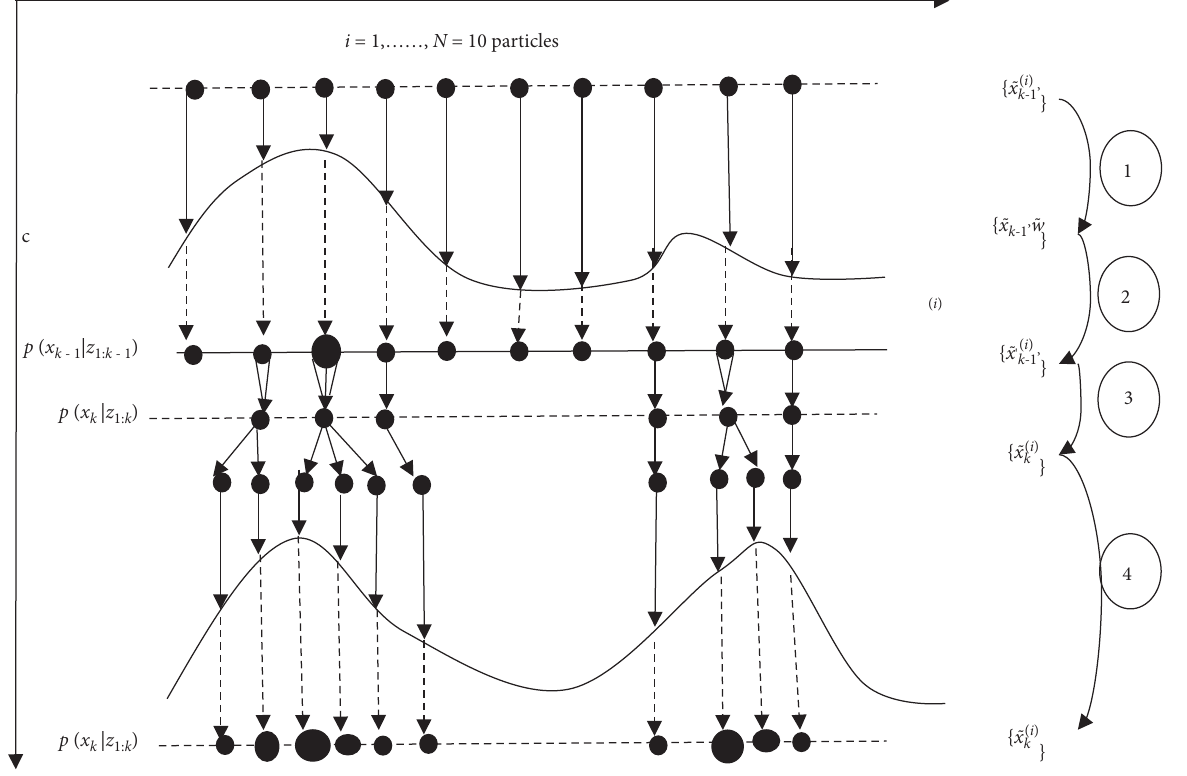
Figure 6: Schematic diagram of particle resampling.